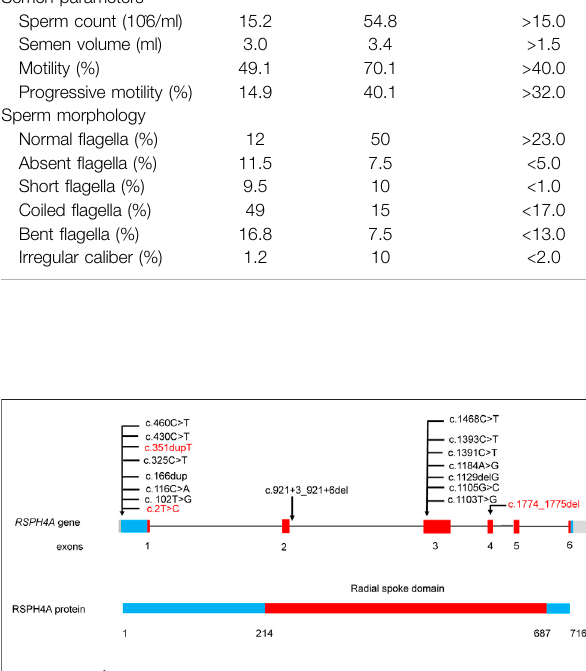
Frontiers in Genetics |